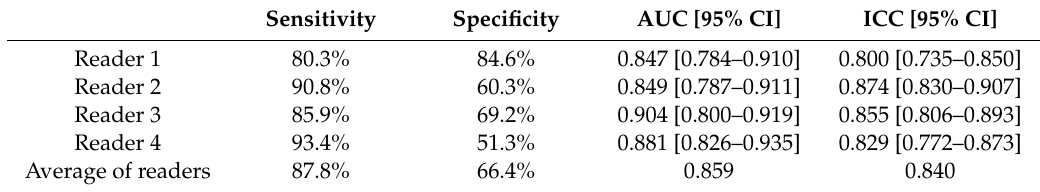
Table 4. Diagnostic performance and interobserver agreement of readers.